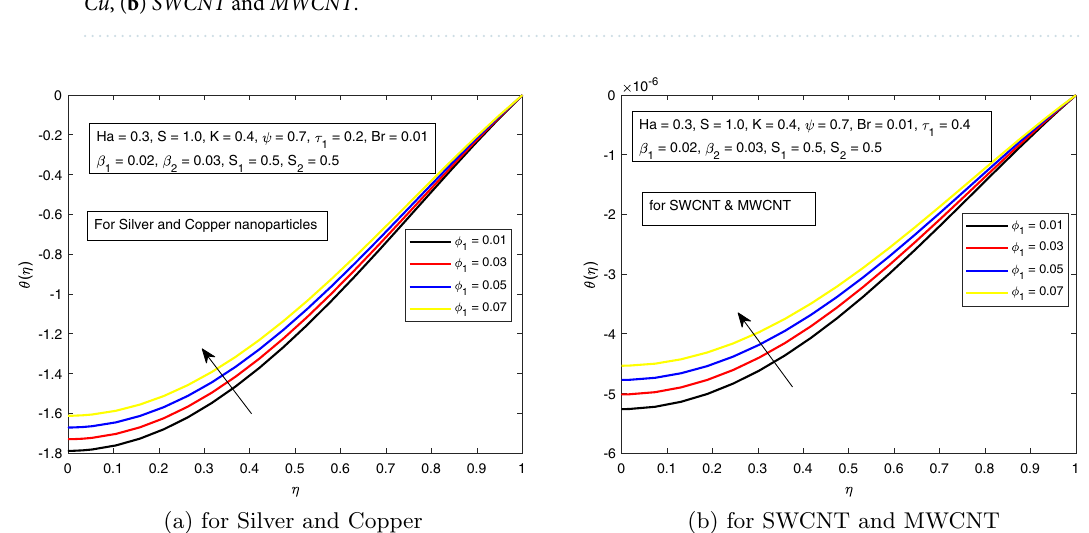
Figure 10. Influence of φ 1 on temperature distribution θ( r ) for the hybrid nanofluid combination of ( a ). Ag and Cu , ( b ) SWCNT and MWCNT